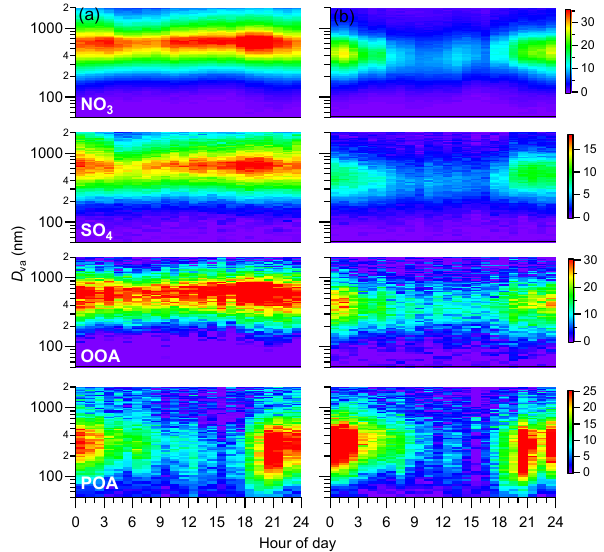
Figure 8. Diurnal evolution of the size distributions of NR-PM 1 species measured (a) before the Asia-Pacific Economic Cooperation (APEC) and (b) during